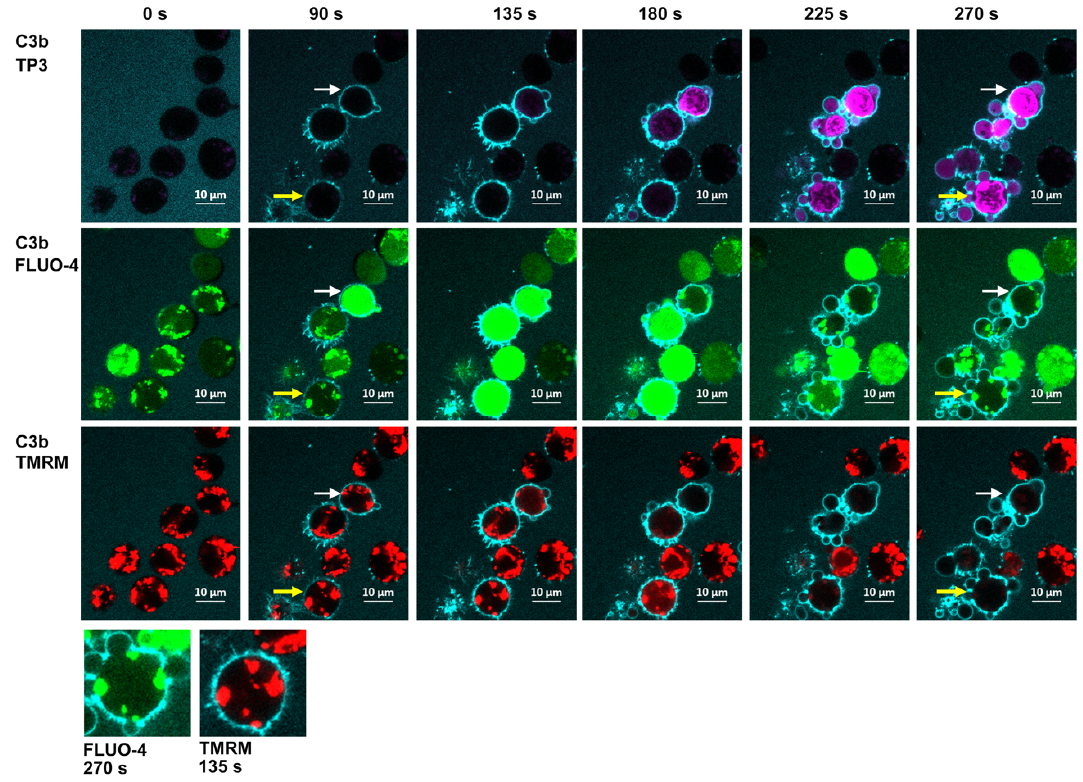
Figure 9. Four-color confocal fluorescence microscopy analyses of the kinetics of CDC of Raji cells mediated by 7D8-Hx. Delineation of discrete steps in CDC of Raji cells: four-color confocal fluorescence microscopy analyses of the kinetics of CDC of Raji cells mediated by 7D8-Hx. For clarity, images based on analyses with two colors at advancing times during the reaction are displayed. Upper panel: Al405 mAb 3E7 (C3b / iC3b, light blue) and TO-PRO-3 (dead cells, bright purple). Middle panel: Al405 mAb 3E7 (C3b / iC3b) and Fluo-4 (Ca 2 + , green). Lower panel: Al405 mAb 3E7 (C3b / iC3b) and TMRM (viable mitochondria red). White arrows mark a representative cell in the transition state at 90 s and dead at 270 s. Yellow arrows identify a cell in which the mitochondria remain viable through the transition-state intermediate. Inset: Amplified image of a single cell at 270 s (Fluo-4) and 135 s (TMRM). Note that the green signal due to Fluo-4 in the dead cell (at 270 s) is localized to places in the live cell in which viable mitochondria (positive TMRM staining) are identified at 135 s. Representative of more than 10 similar experiments